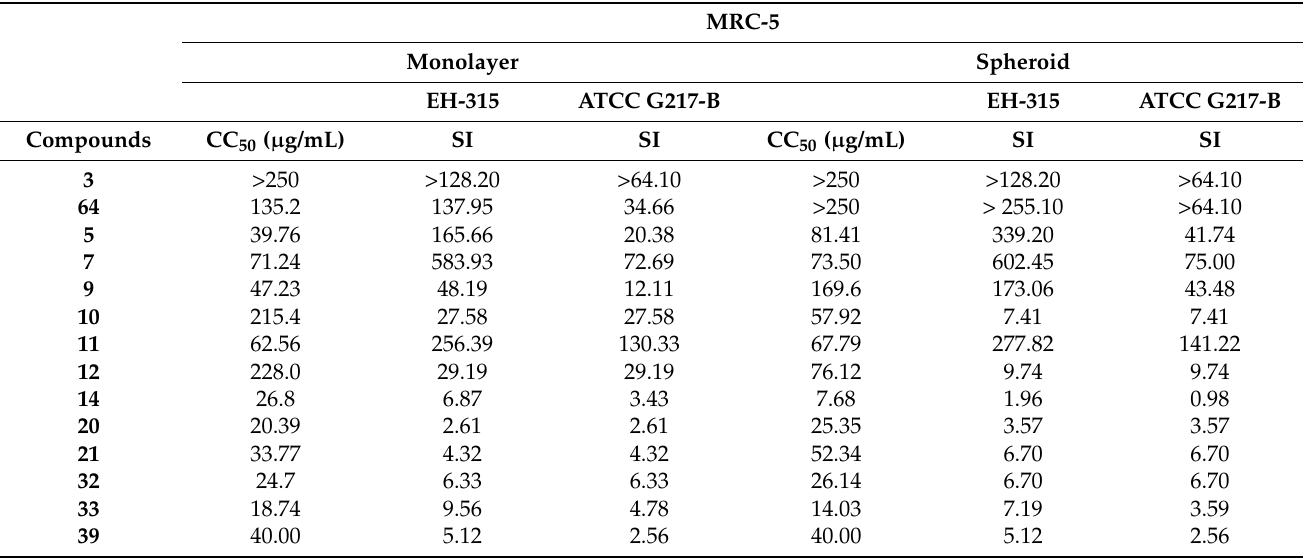
Table 5. Values of CC 50 ( µ g/mL) and SI for the MRC-5 cell line in the monolayer and the 3D model treated with nitrofuran and indole